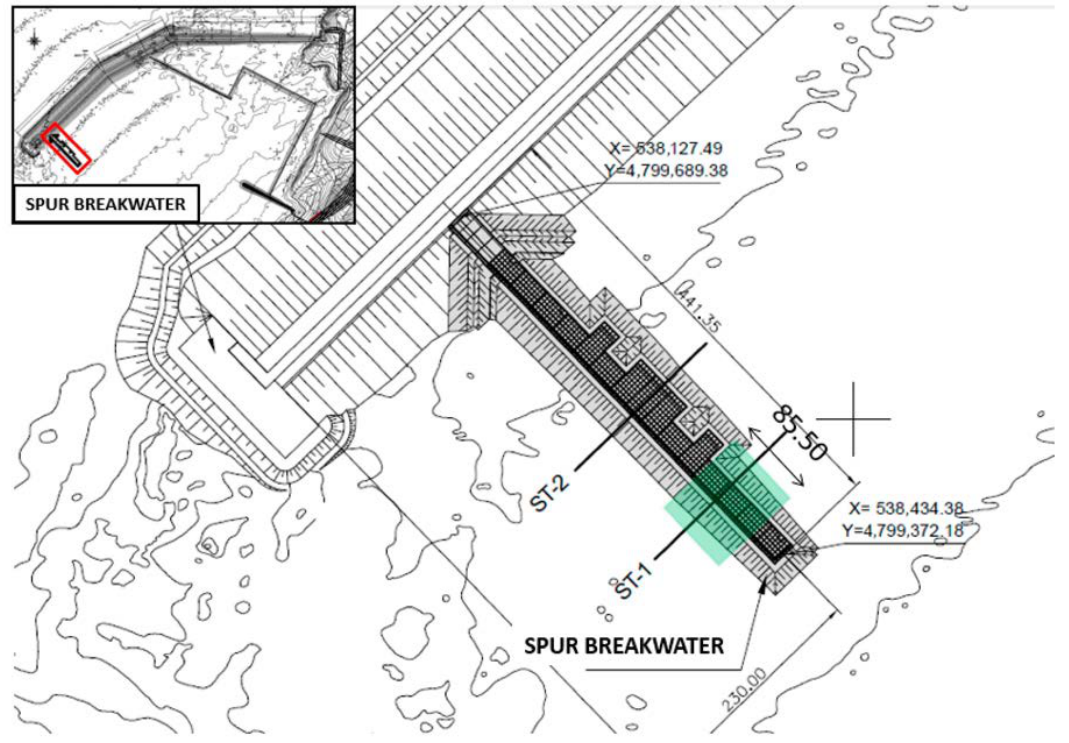
Figure 6. Plan of the spur breakwater of the Outer Port of A Coruña (Langosteira).